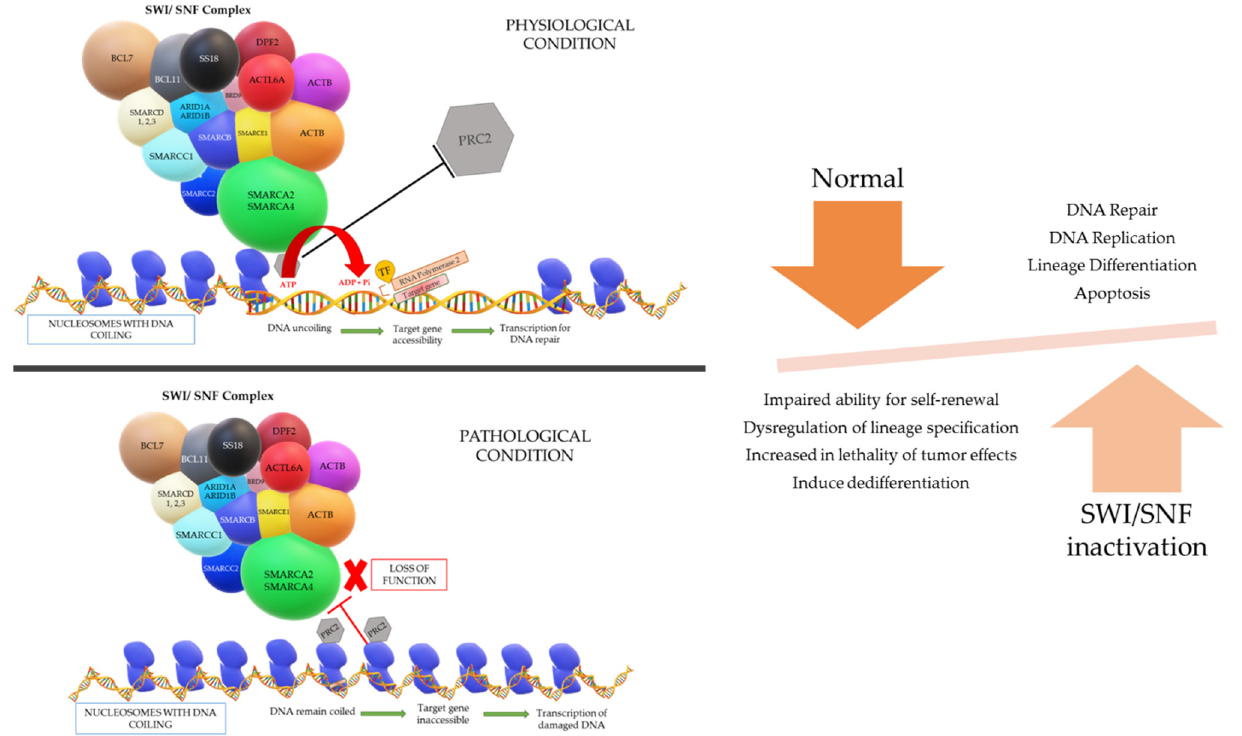
Figure 1. The loss of function of the SMARCA2/A4 catalytic subunit within the SWI/SNF complex due to the inactivation of the SMARCA4 gene will lead to an increase in DNA damage functionality as PRC2 will continue to bind to the nucleosome and the target gene for DNA repair will be inaccessible as the DNA remains coiled. This will promote the malignant behavior of cancer cells.